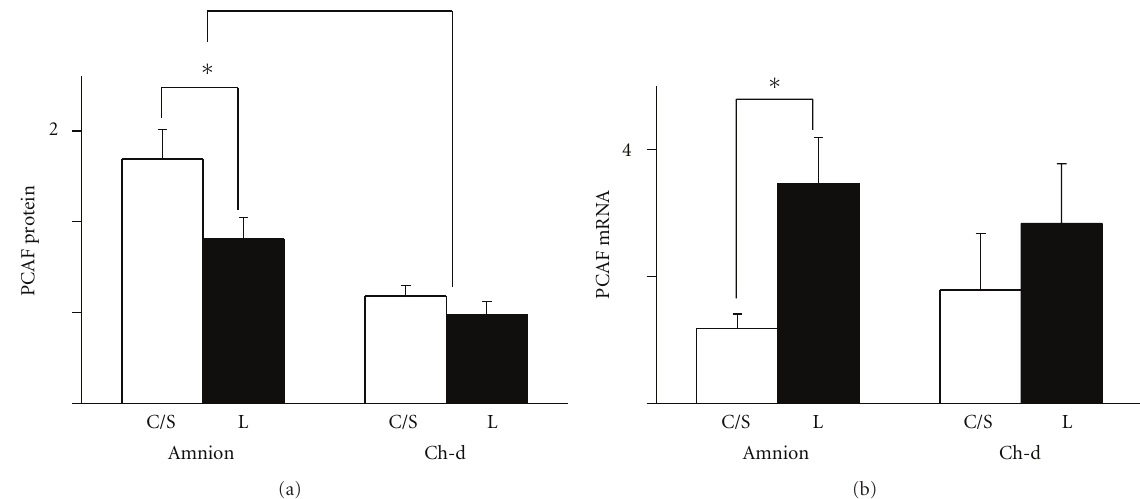
Figure 5: Expression of PCAF protein (a) and mRNA (b) in the amnion and chorion-decidua (Ch-d) from non-labor group (C/S) and labor group (L). Data were presented as the mean ± SEM. (a) ∗∗ P < 0 . 05 between amnion and chorion-decidua. ∗ P < 0 . 05 between C/S group and labor group within the amnion. (b) ∗ P < 0 . 05 between C/S group and labor group within the amnion. Ponceau S staining was used as the internal control for Westerns and GAPDH mRNA as the internal control for